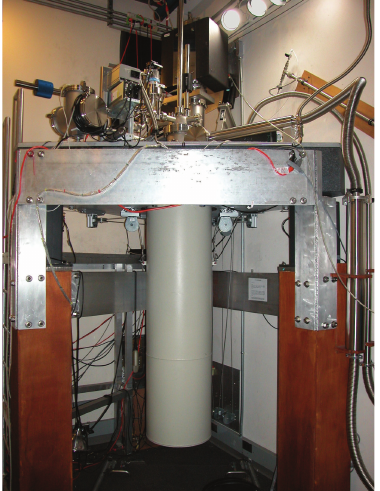
Figure 11: Scanning tunneling microscopy (STM), a custom design- ed UHV, variable temperature scanning tunneling microscope, Eric Hudson Group.